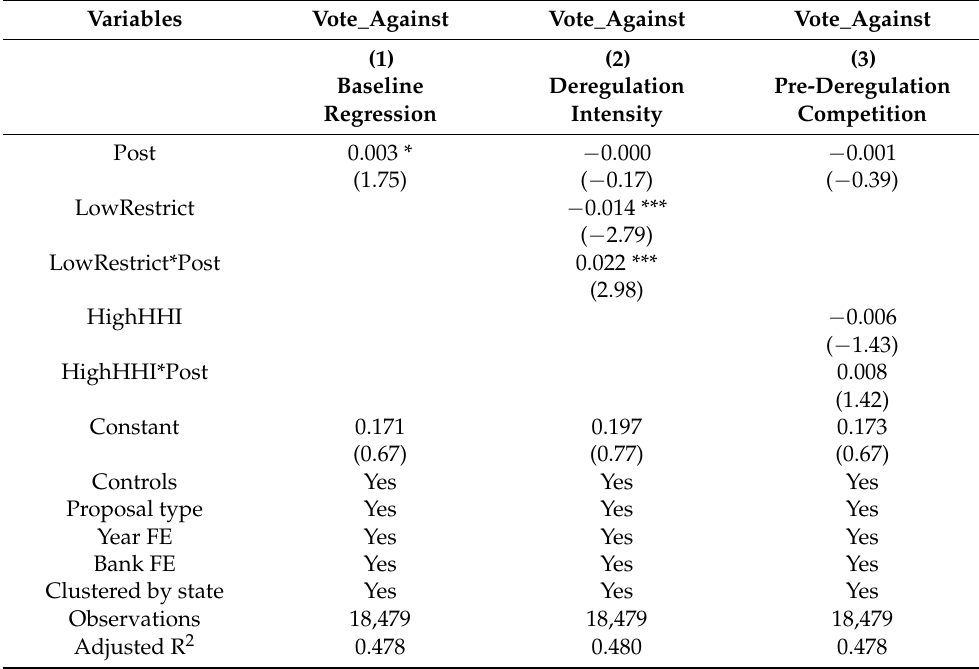
Table 6. Sample including shareholder-sponsored